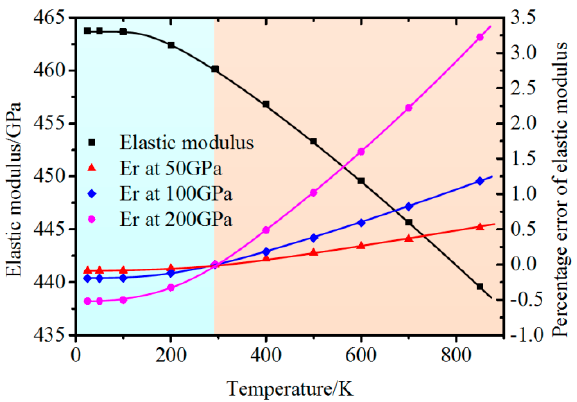
Figure 14. Percentage error of calculation elastic modulus at different temperatures [33].